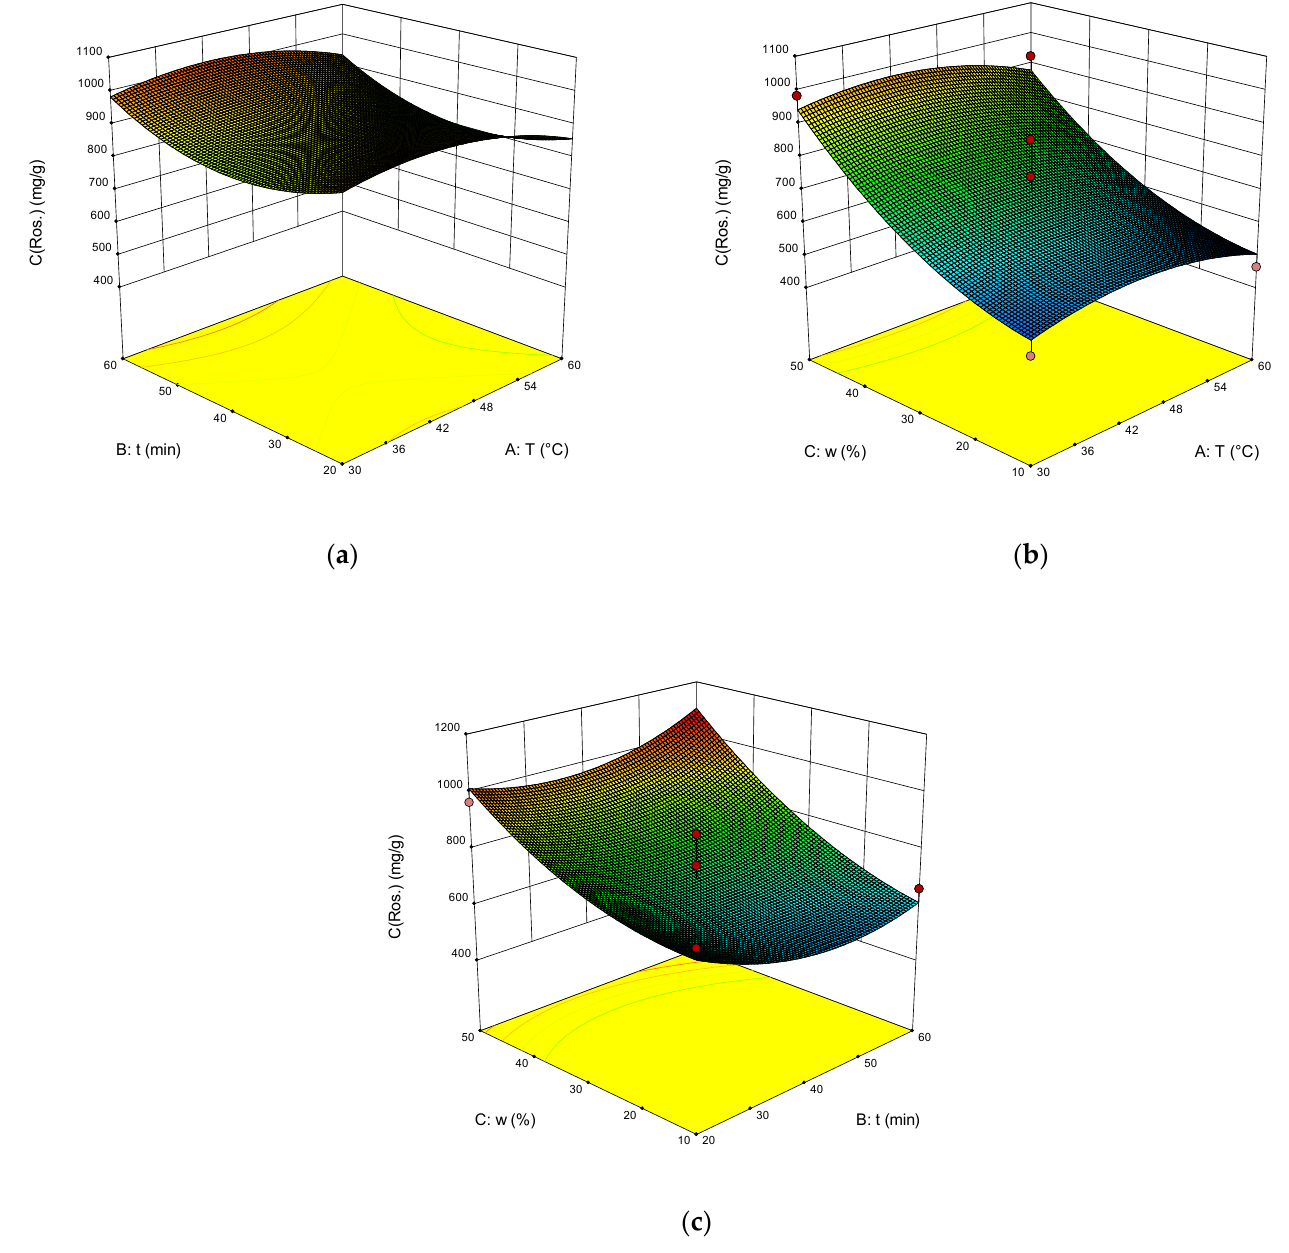
Figure 3. The response surface ( a – c ) shows the effect of extraction temperature (A), extraction time (B) and water content (C) on the extraction yield of rosavin.